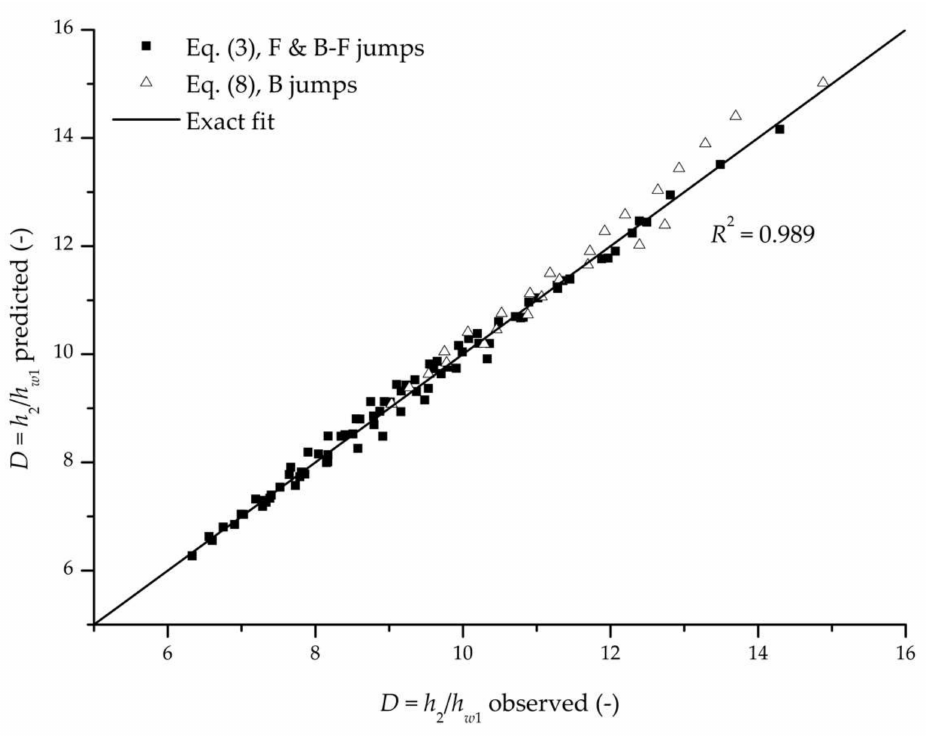
Figure 8. Observed vs. predicted sequent depth ratios.